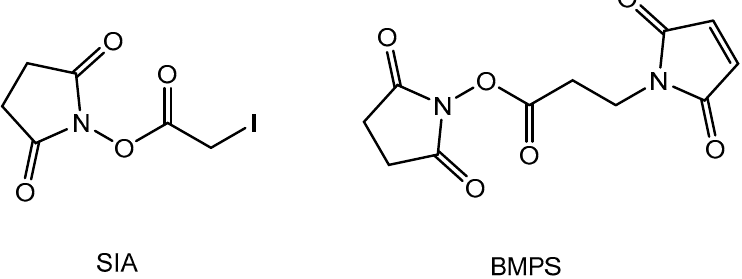
Figure 1. Structures of the activation reagents succinimidyl iodoacetate (SIA) and N -( β -maleimidopropyloxy) succinimide ester (BMPS).